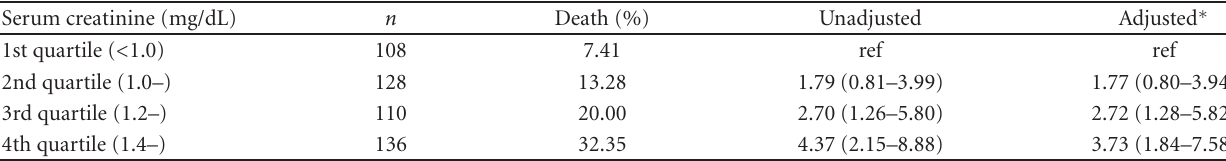
Table 4: Risk ratios and 95% confidence intervals for all-cause mortality based on serum